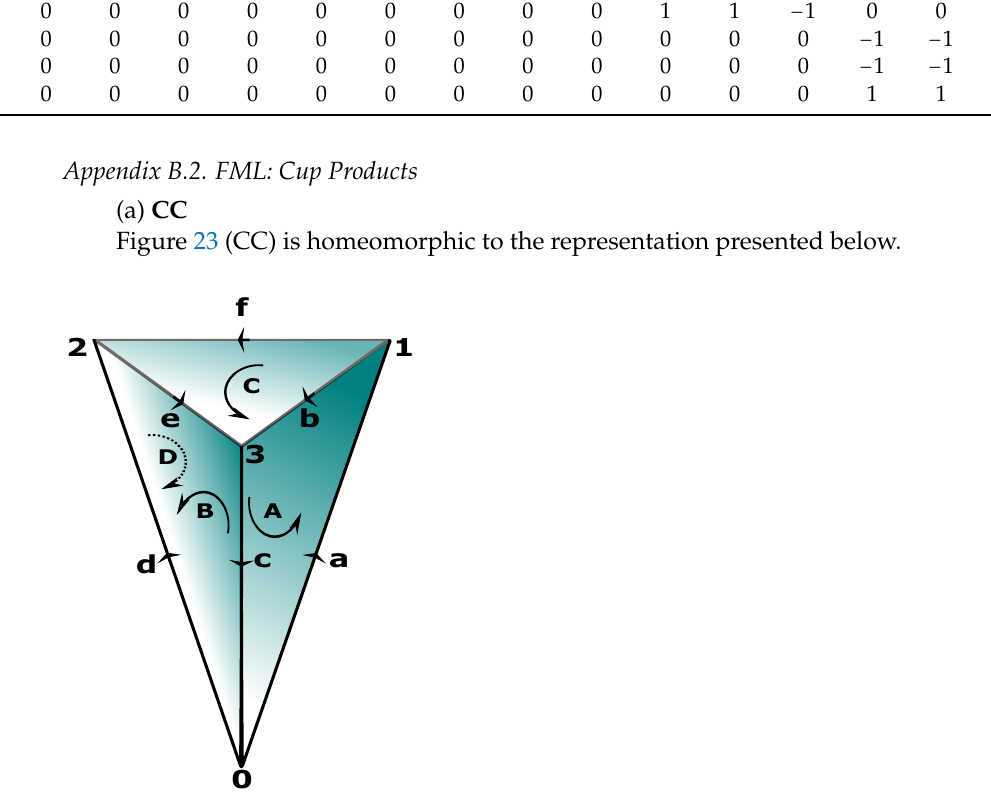
Figure A9. Homeomorphic representation of the TI read by CC at